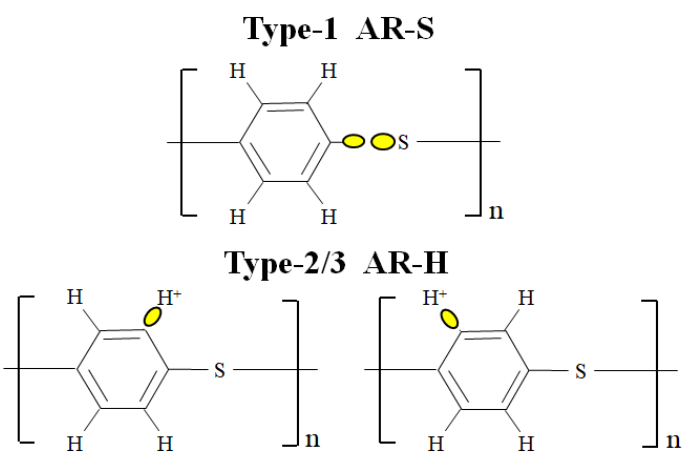
Figure 14. Constitutional formula of PPS with three types of dangling bonds assumed from Figure 13.